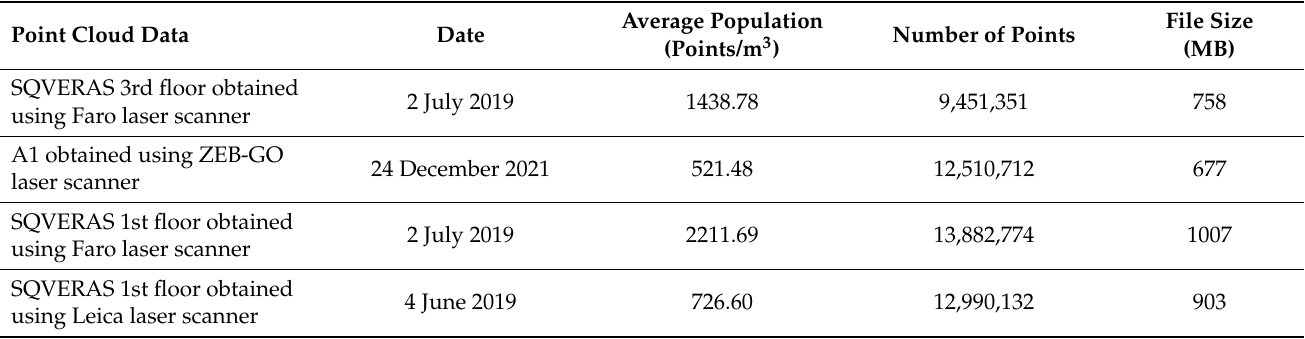
Table 3. Main parameters of point cloud data.